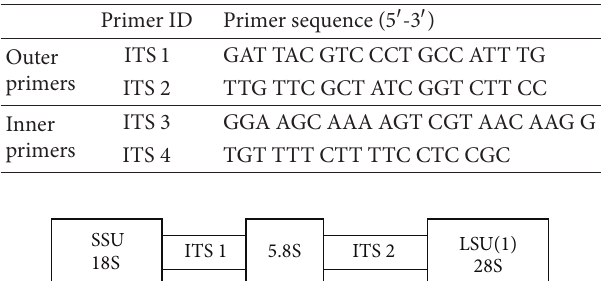
Table 1: Sequence of primers.